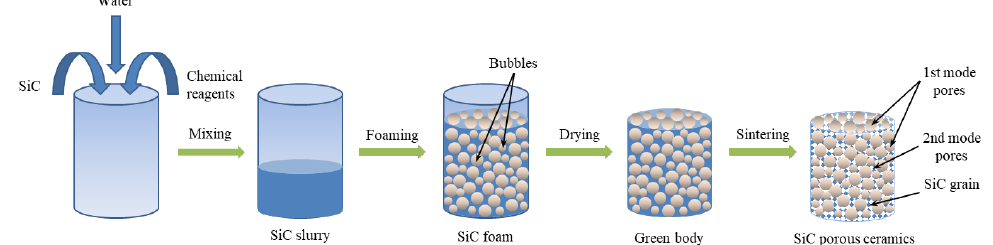
Figure 3. Schematic illustration of the porous structures formation mechanism.